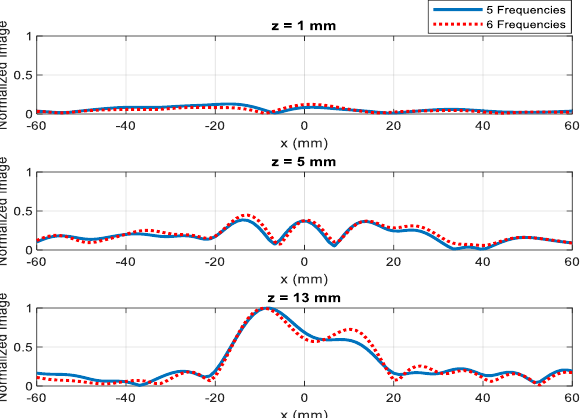
Figure 16. Reconstructed 1D images for copper strips placed at a depth of 13 mm when using data at 5 and 6 frequencies.